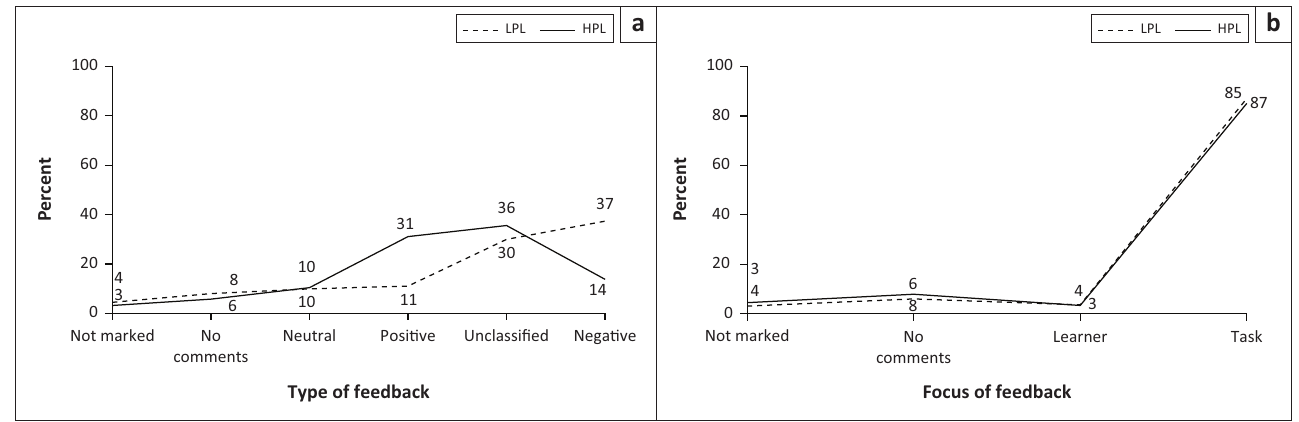
FIGURE 7: (a) Type of feedback for low- and high-performing learners; (b) Focus of feedback for low- and high-performing learners.